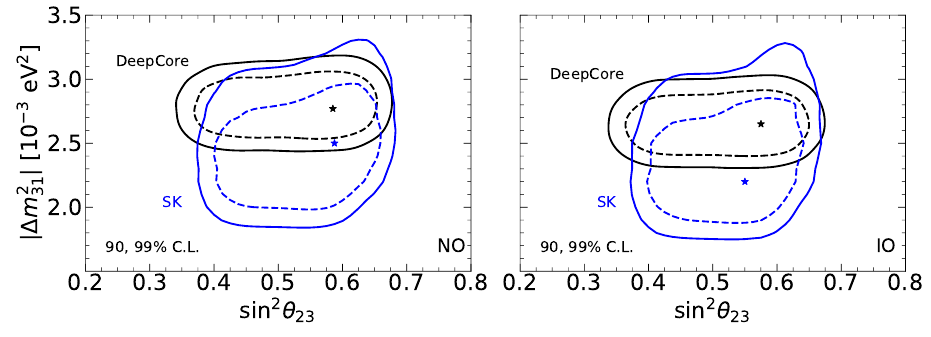
Figure 3 . 90 and 99% C.L. (2 d.o.f.) allowed regions at the sin 2 θ 23 – ∆ m 2 and IO (right), obtained from the analyses of Super-Kamiokande (SK) atmospheric (blue) and DeepCore (black) data. The best fit values are indicated by